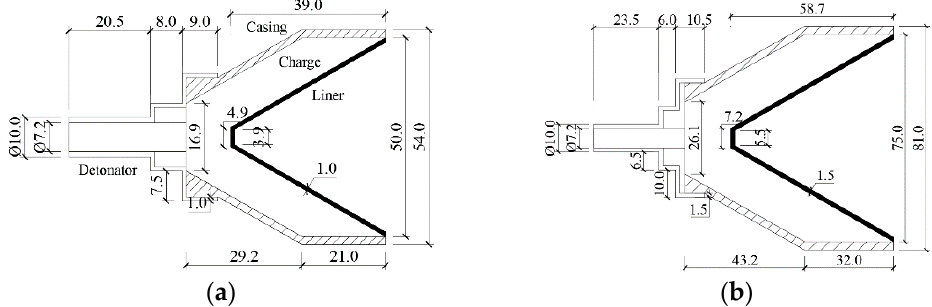
Figure 2. Experimental shaped-charge size (unit: mm): ( a ) Small; ( b ) Medium.